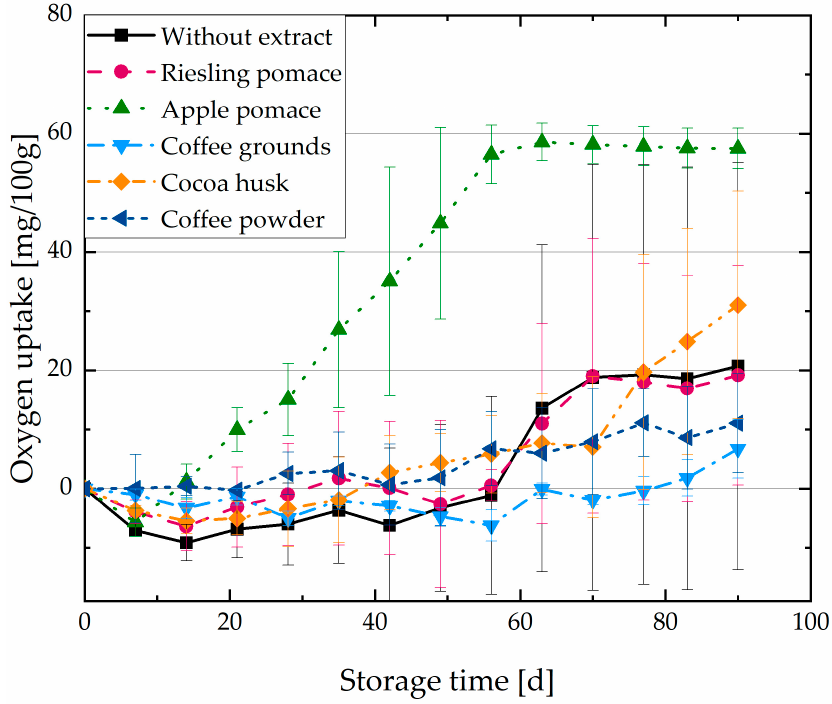
Figure 3. Oxidation kinetics of natural cosmetic emulsions with plant extracts stored in light. The figures show the oxygen uptake in mg O 2 per 100 g as a function of the storage time at 30 °C for the O/W emulsions with and without extract, as mean values ( n = 3) with standard deviation (SD).